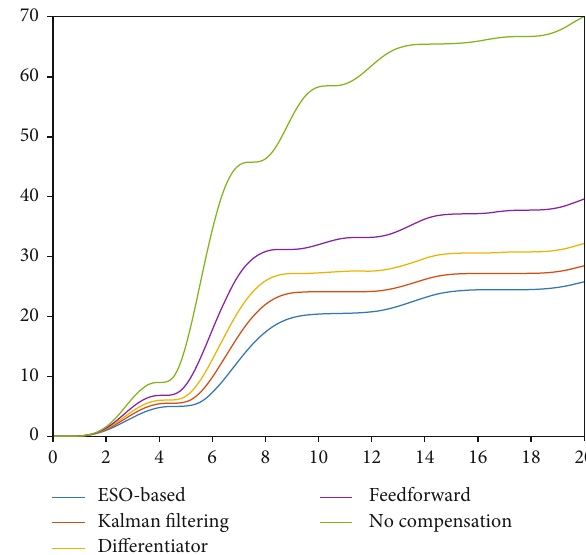
Figure 25: E ff ect of target constant maneuver.